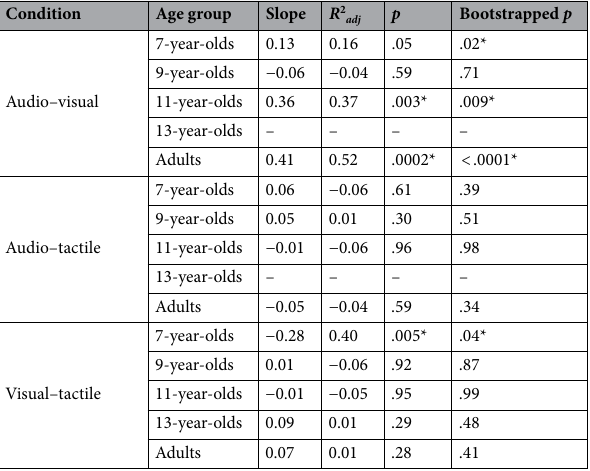
Table 1. Results of the regression analyses between the PSS shifts and the widths of simultaneity window for the three cross-modal pairings across age groups. Asterisks indicate that the slope of the statistical tests was significant (i.e., linear regression analyses or bootstrap hypothesis